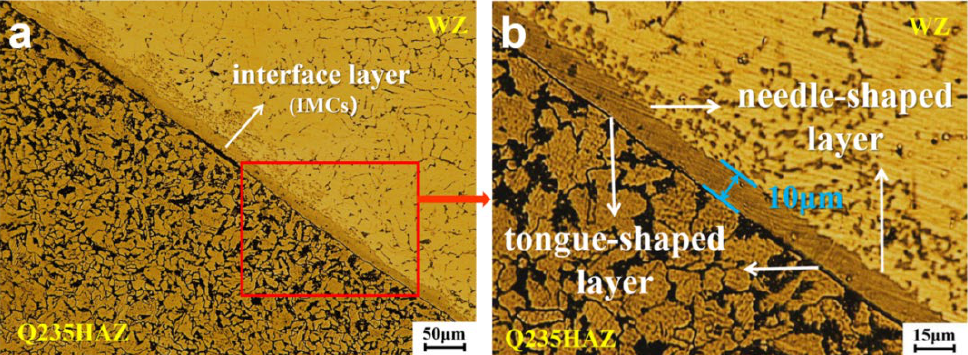
Figure 6. Microstructure of interface layer: ( a ) microstructure under 50 μm; ( b ) microstructure under 15 μm.